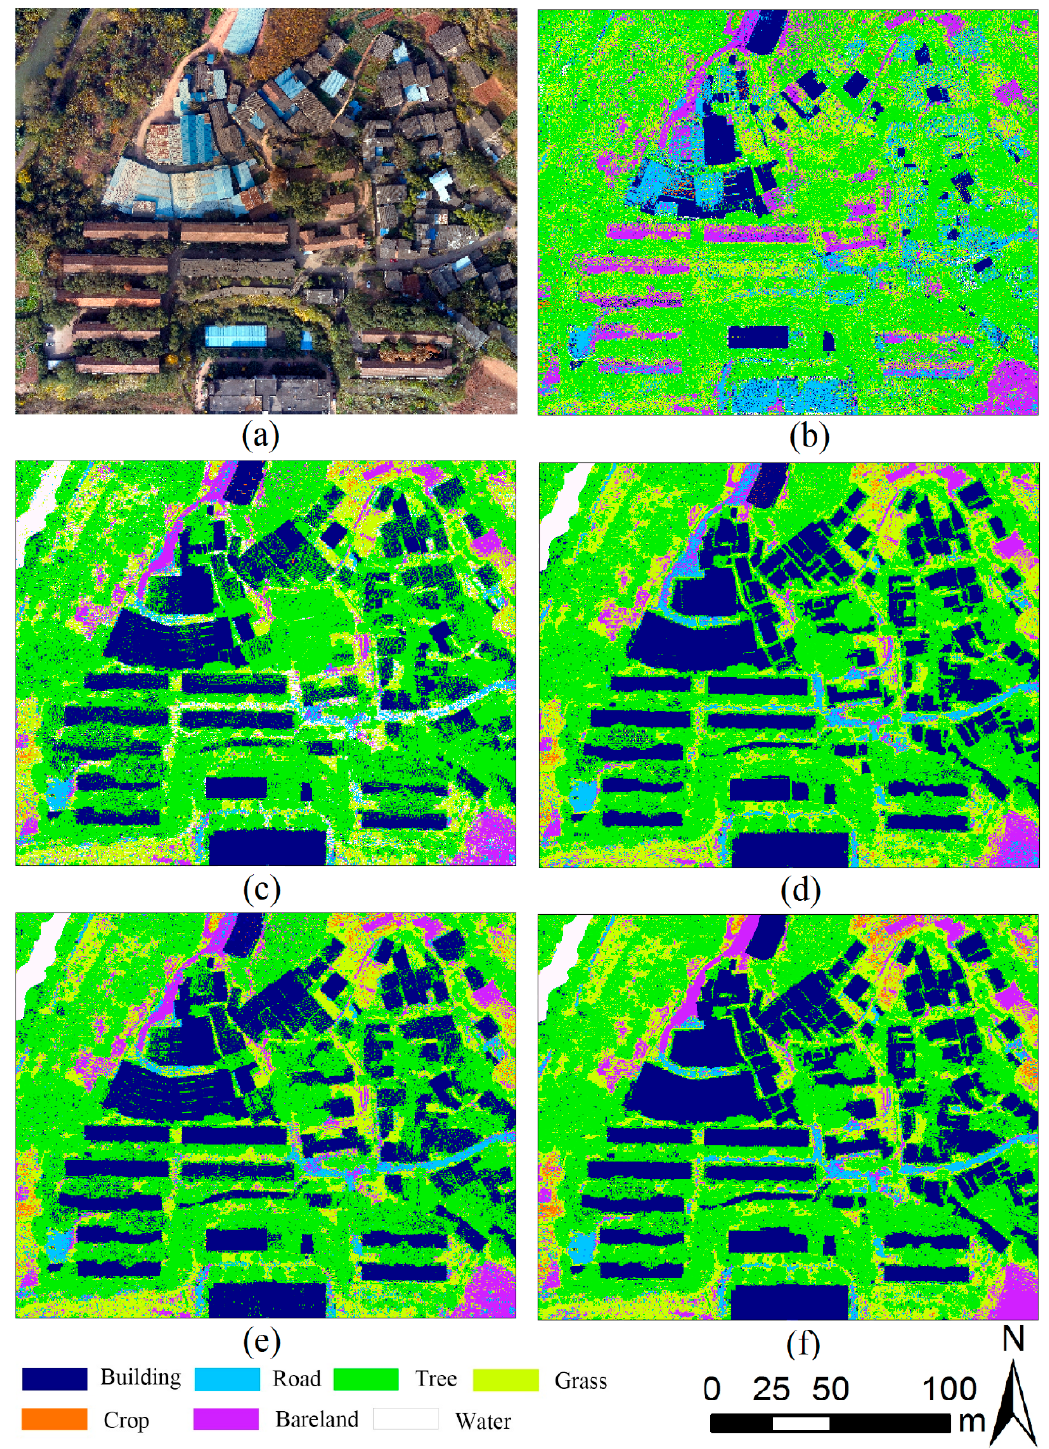
Figure 13. Subgraph of classification results for the five scenarios obtained by using RF classifier: ( a ) the corresponding aerial imagery of the subgraph; ( b ) scenario 1 classification result subgraph with input data of RGB; ( c ) scenario 2 classification result subgraph with input data of RGB and nDSM; ( d ) scenario 3 classification result subgraph with input data of RGB, nDSM, and RM; ( e ) scenario 4 classification result subgraph with input data of RGB, nDSM, and IM; ( f ) scenario 5 classification result subgraph with input data of RGB, nDSM, RM, and IM.